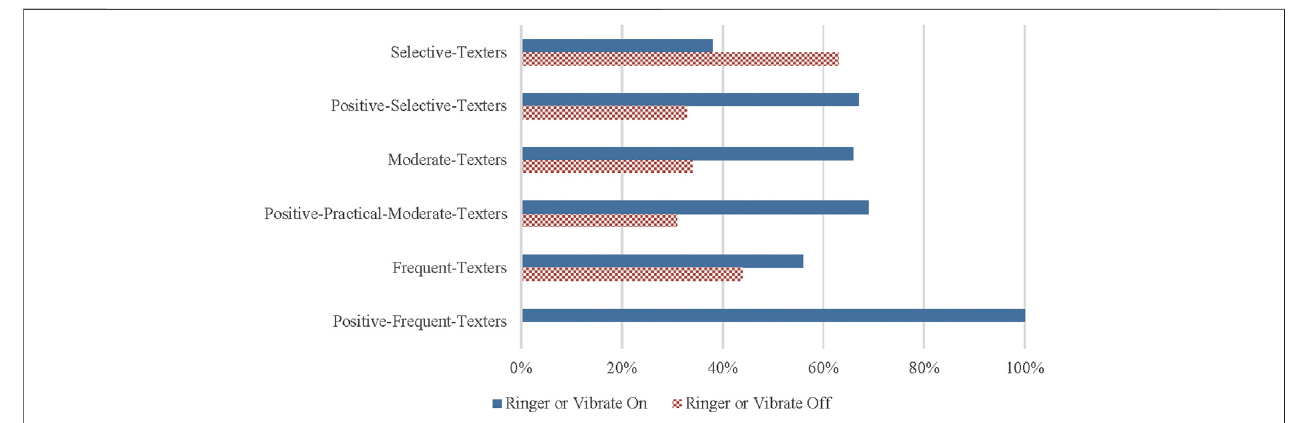
FIGURE 3 | Cell phone mode when completing